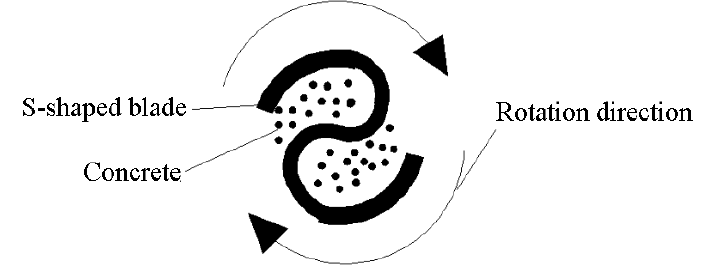
Figure 2. Working principle diagram of pile forming mold.